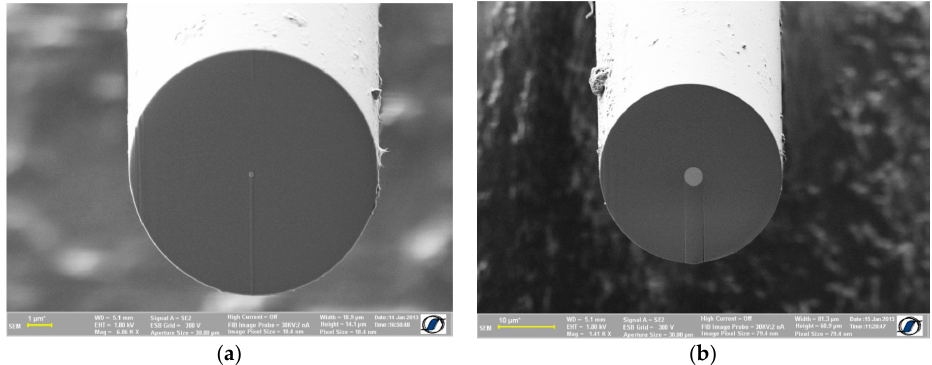
Figure 4. SEM micrographs of: ( a ) a glass-coated Fe 73.5 Cu 1 Nb 3 Si 13.5 B 9 nanowire with the metallic nucleus diameter of 185 nm and the glass coating thickness of 5 μ m; and ( b ) a glass-coated microwire with the same composition, but with the nucleus diameter of 3.5 μ m and the glass coating thickness of 10 μ m.